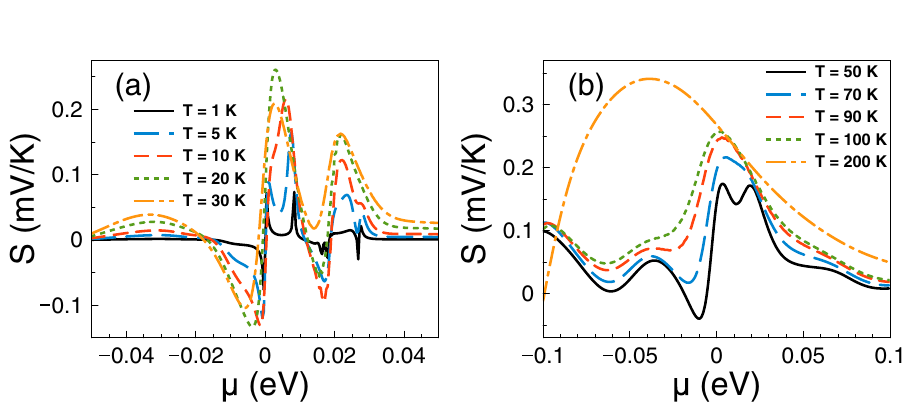
Figure 16. The same as Fig. 9, but for d B = d W = 10 nm. Here, in addition to the contribution of the Breit– Wigner resonances we can see the contribution of the so-called hybrid resonances at about 26 meV, see the inset in (a).